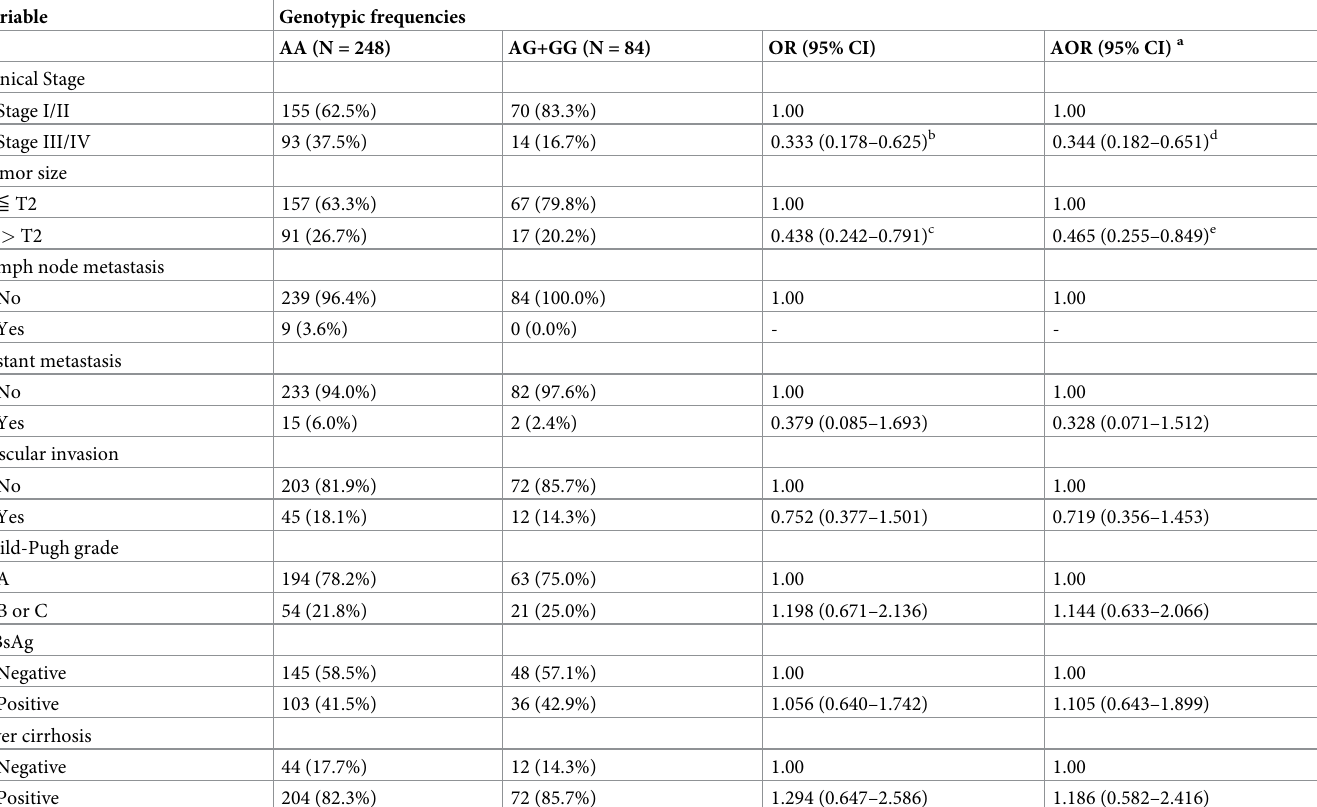
Table 3. Odds ratio (OR) and 95% confidence interval (CI) of clinical status and WISP1 rs62514004 genotypic frequencies in 332 HCC